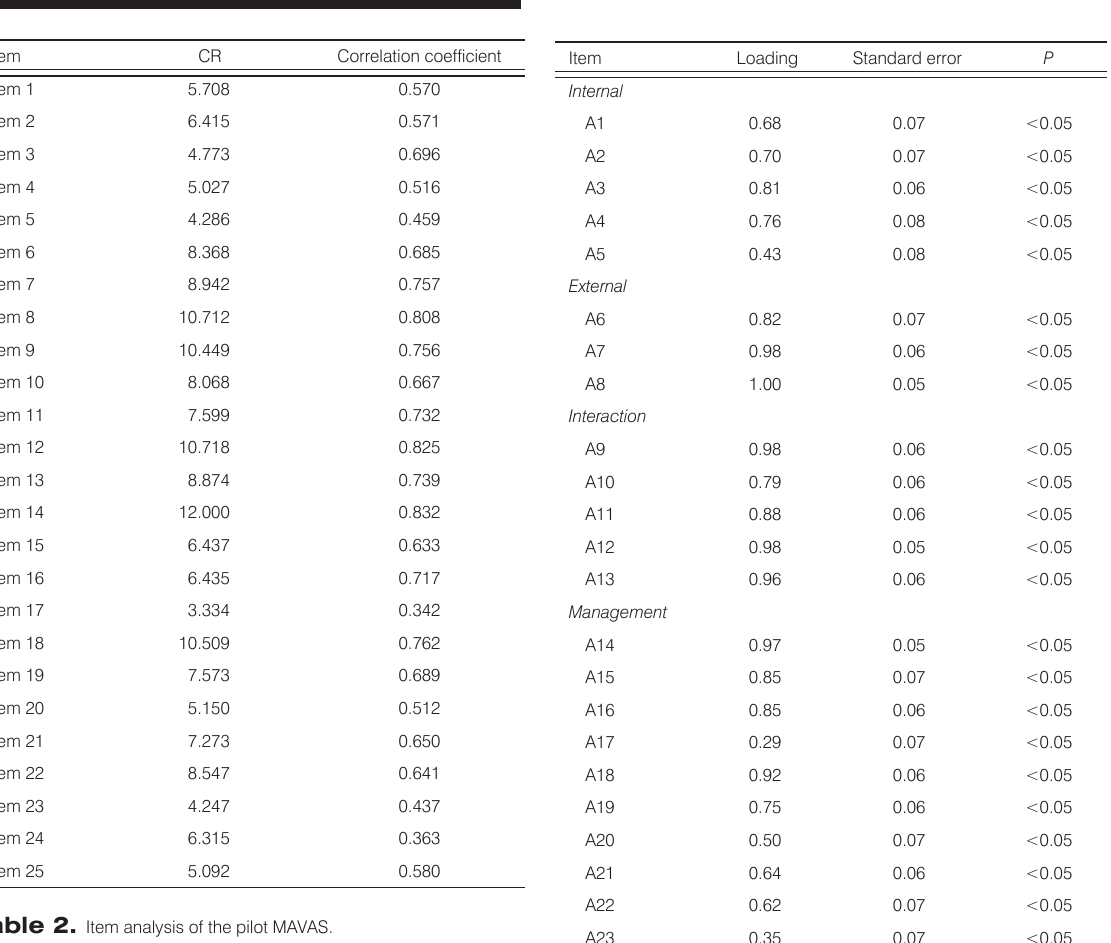
Table 2. Item analysis of the pilot MAVAS.